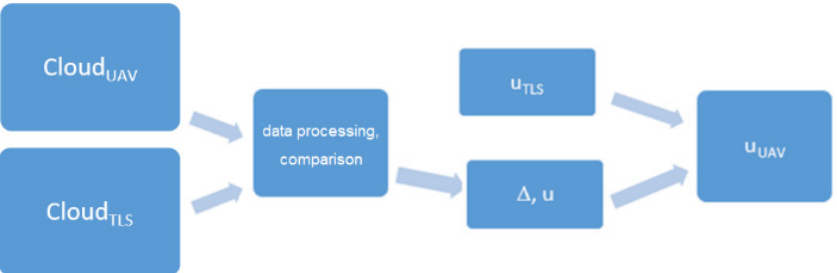
Figure 14. Algorithm of the unmanned aerial vehicle (UAV) method accuracy estimation, where Cloud TLS and Cloud UAV are clouds of points related to the terrestrial laser scanning (TLS) and UAV methods, respectively, ∆ and u are absolute values of occurred errors and related uncertainties, u TLS and u UAV are measurement uncertainties characterizing the TLS and UAV methods, respectively.